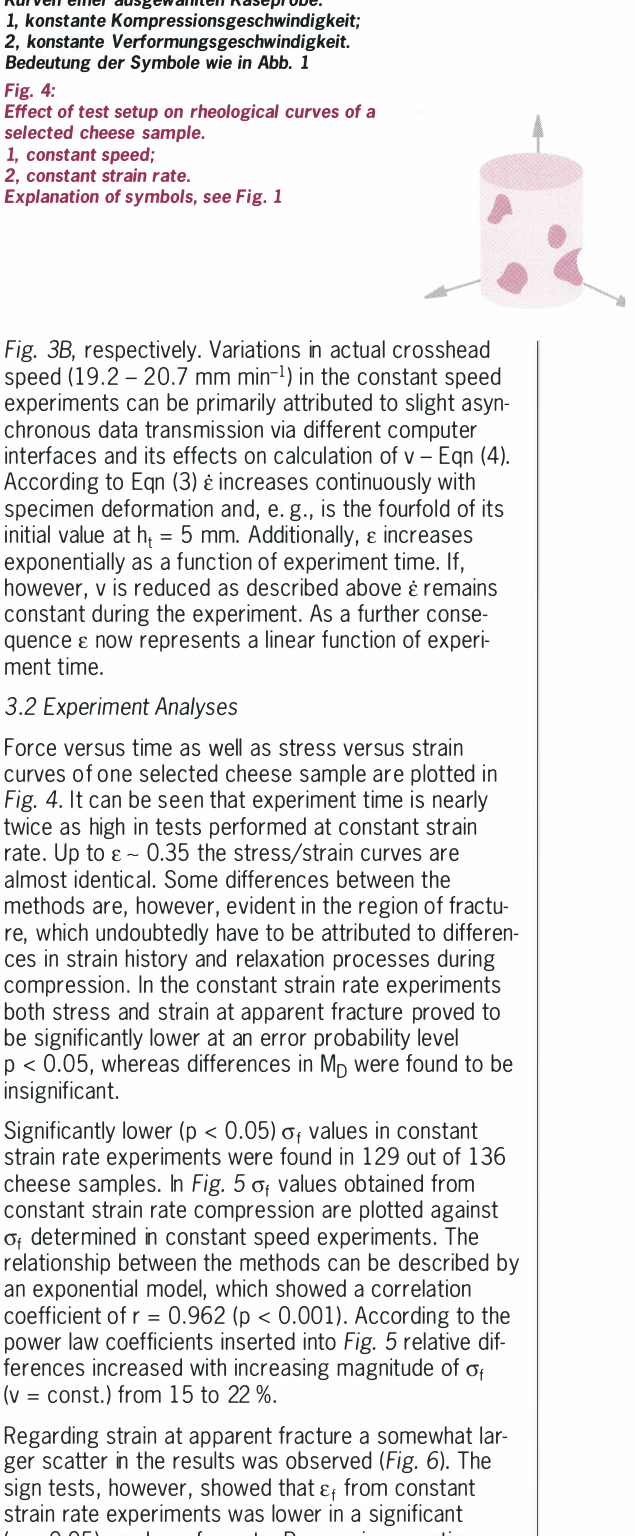
Fig. 5: Influence of test setup on stress at apparent fracture (n = 136) -:-320 - 1; c